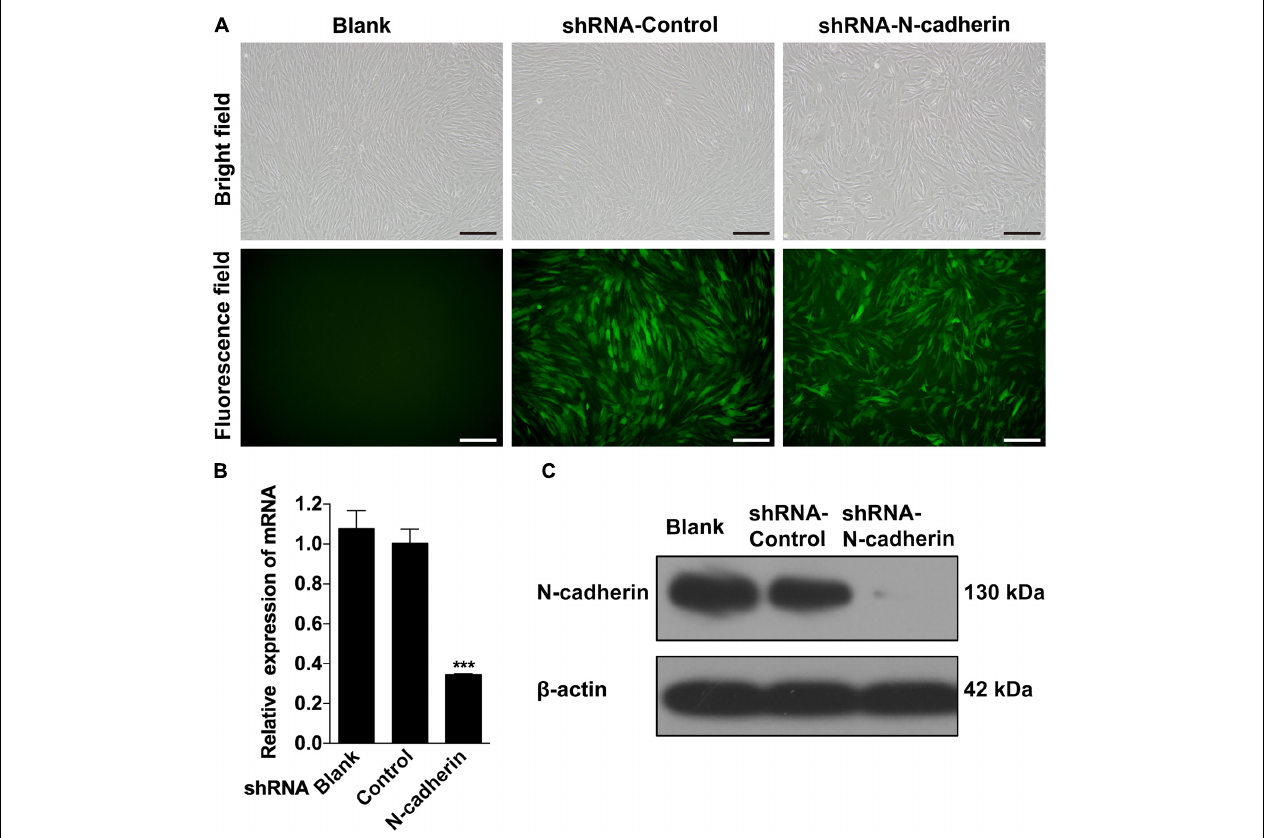
FIGURE 2 | Stable downregulation of N-cadherin in dental pulp stem cells (DPSCs). DPSCs were transfected with either the N-cadherin shRNA or control shRNA lentivirus. The transfection efficiency was evaluated using fluorescence microscopy (A) . The expression level of N-cadherin mRNA and protein were detected by qPCR and western blotting, respectively (B,C) . Scale bars = 200 µ m. Data are presented as the mean ± SEM of three independent experiments. *** P <